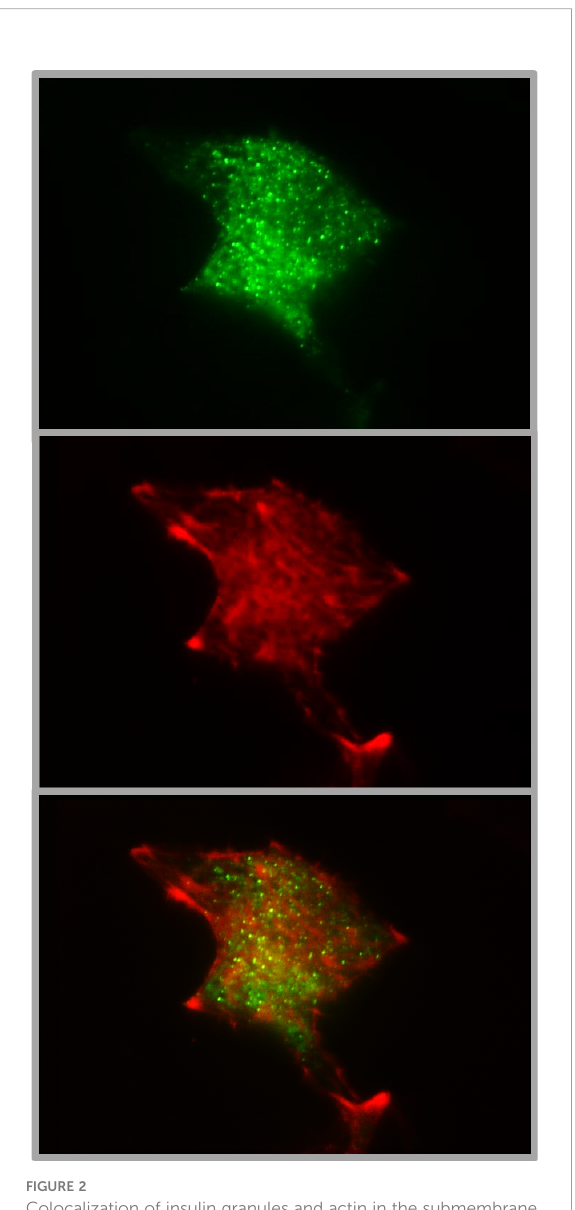
FIGURE 2 Colocalization of insulin granules and actin in the submembrane space of MIN6 cells. The insulin granules of MIN6-cells (p20 - p30) were labeled by transient transfection with hIns-EGFP and mTagRFP-T-Lifeact-7. The fl uorescence emission < 560 nm (upper image) gives the conventional TIRFM image of green fl uorescent granules in the submembrane space (calculated decay constant 85 nm). The fl uorescence emission > 560 nm shows the presence of red-labelled actin (middle image) together with insulin granules (overlay, lower image) in the same space. The coexistence suggests that the granule mobility may re fl ect, at least in part, interactions with the cortical